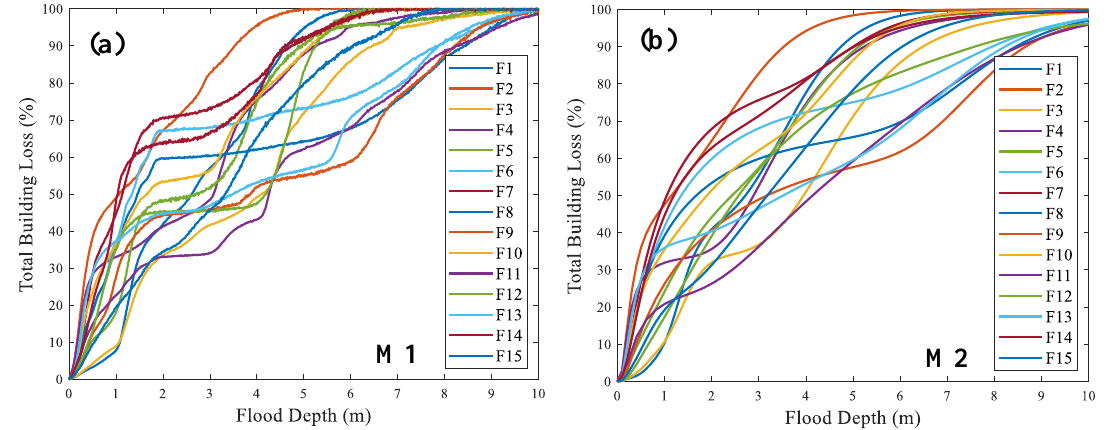
Figure 9. Building archetypes’ normalized loss curves: ( a ) Loss curves using direct loss approach (M1); ( b ) Loss curves using fragility-based approach (M2).